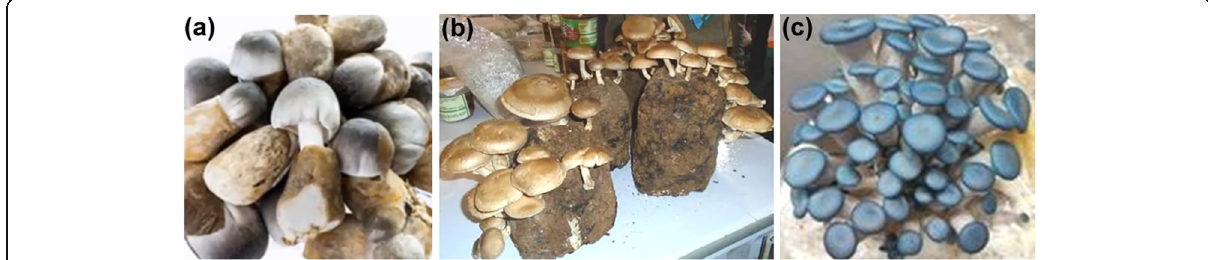
Fig. 4 The a harvested paddy straw mushroom ( Volvariella volvacea ), b shiitake mushroom ( Lentinula edodes ), and c elm oyster mushroom ( Hypsizygne ulmarius ) at cropping